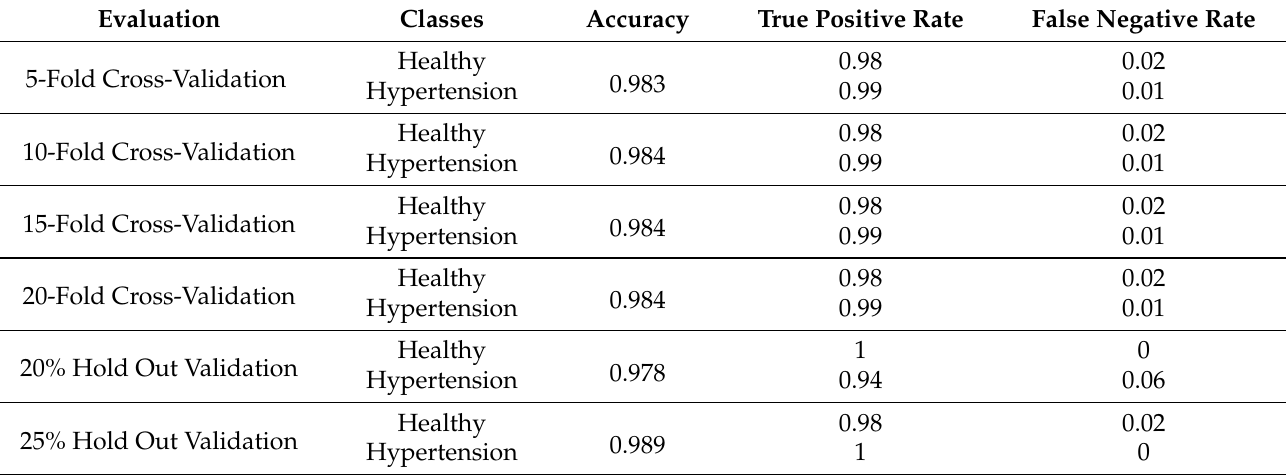
Table 11. Validation of the selected scheme of method